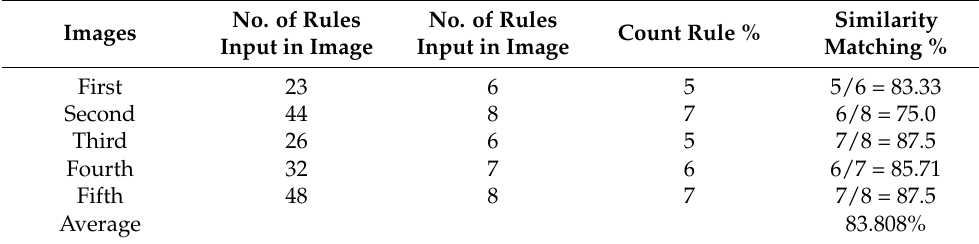
Table 3. Results of dental identification for one sample of dental images.